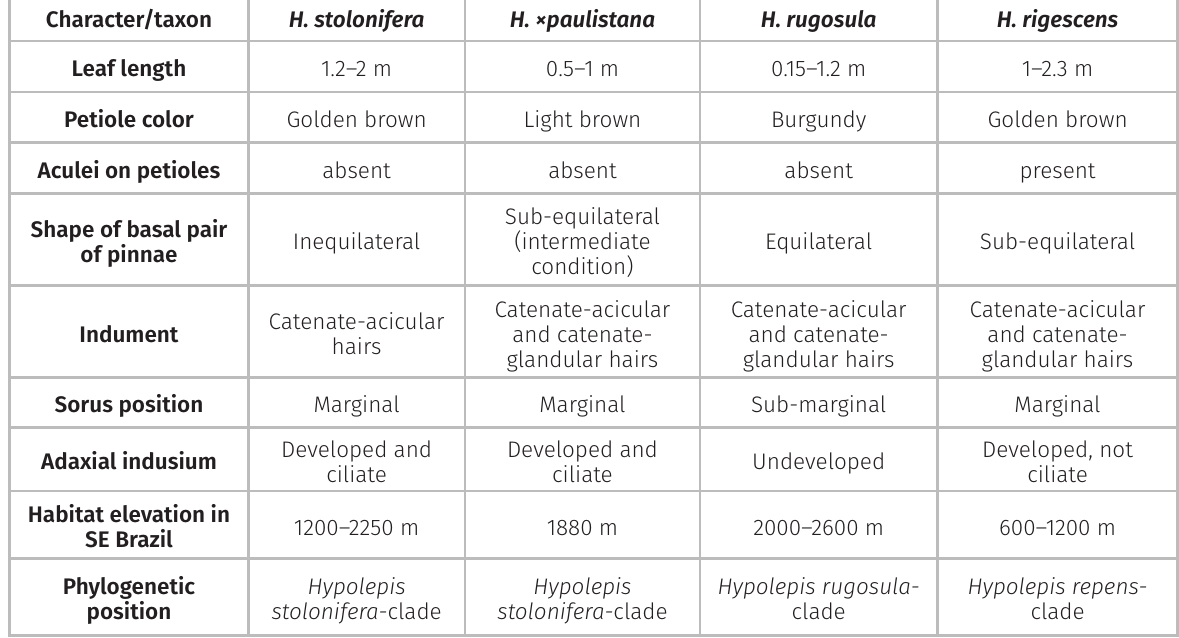
Table I. Morphological and habitat comparisons among Hypolepis ×paulistana and the probable parents.